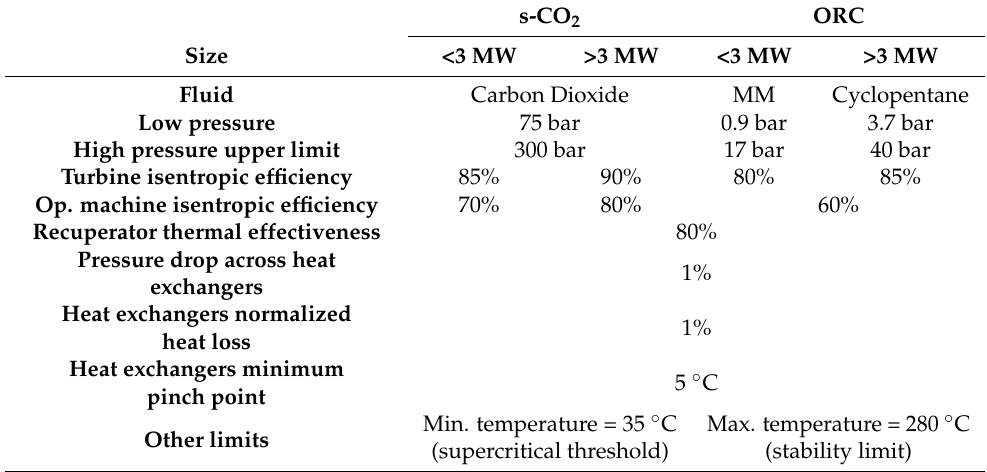
Table 2. Bottomer cycles design